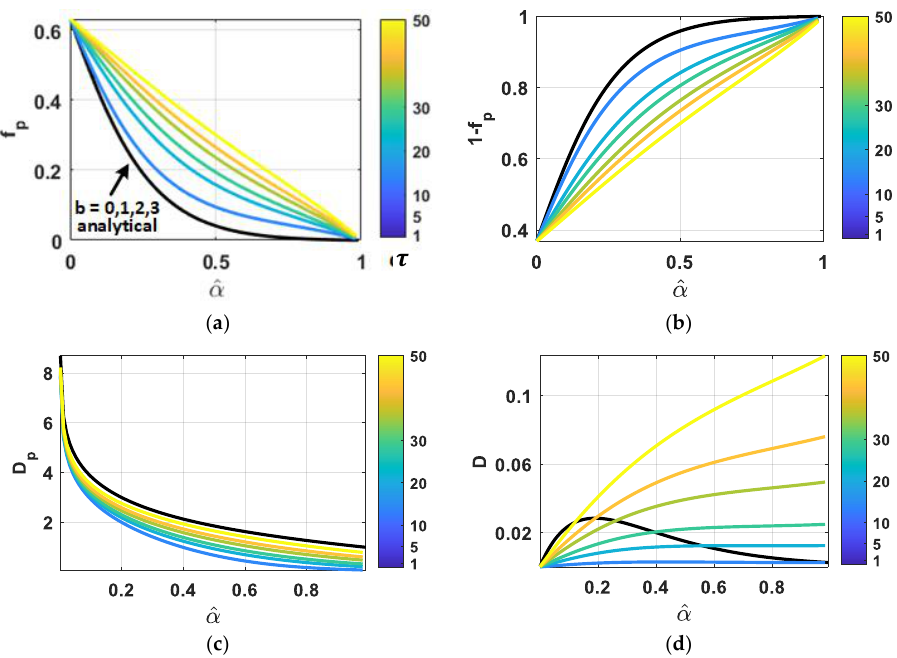
Figure 5. Biexponential parameter estimates as a function of the stretched exponent 𝛼 ̂ . Simulations were implemented by taking uniformly spaced b values with 𝑏 𝑚𝑎𝑥 = 400 and 𝐷 𝑠𝑒 = 1/𝑏 𝑚𝑎𝑥 . Lines encoded with different colors correspond to the sampling interval of b values, 𝜏 , which took discrete values of 1, 5, 10, 20, 30, and 50. The analytical solutions (in black lines) were implemented with 𝑏 = 0,1,2,3 and 𝐷 𝑠𝑒 = 1/400 .